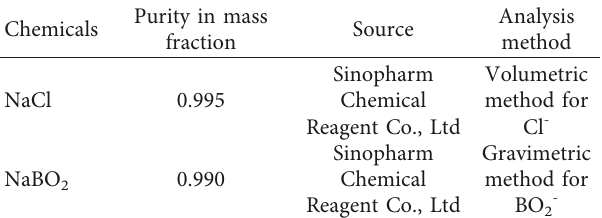
Table 1: Chemicals used in this